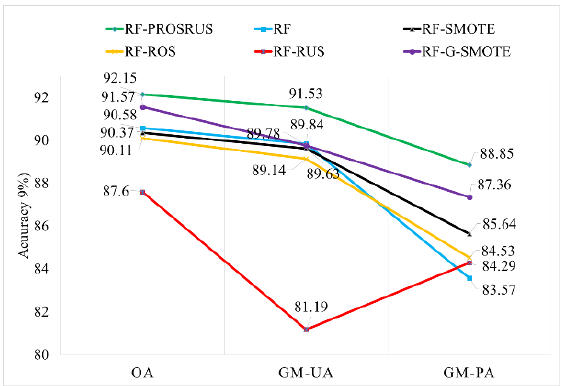
Figure 10. Accuracy assessment of the five resampling methods and the Scenario-4 classification method (i.e., RF with imbalanced samples) over Site-3.